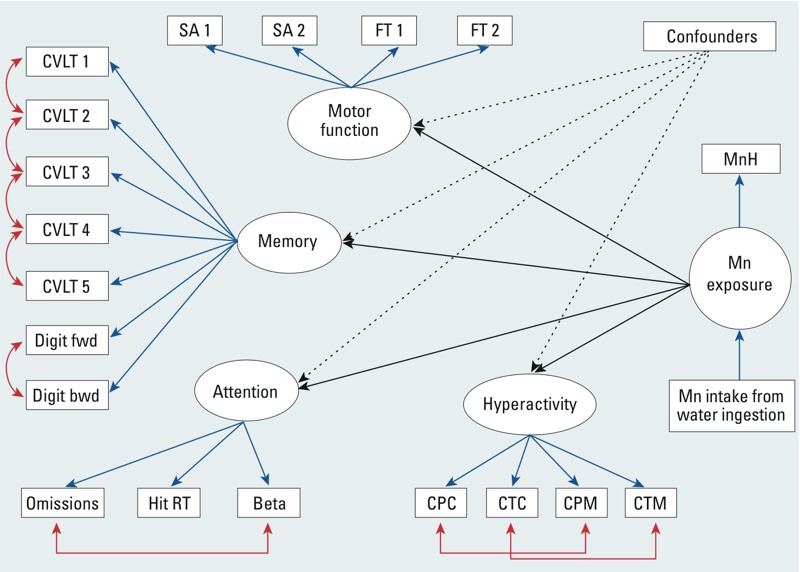
Conceptual path diagram for model 1 of the SEM for the associations between manganese exposure and neurobehavioral functions, with covariates adjustment. Manganese (Mn) exposure was modeled as a latent parameter indicated by hair manganese concentration (MnH), and influenced by manganese intake from water consumption. Four latent neurobehavioral functions were constructed: memory, attention, motor, and hyperactivity. The memory latent function was based on the number of correct responses on the learning trials of the CVLT–C for List A total trials 1–5 free recall (CVLT 1); List A, trial 1 free recall (CVLT 2); List A, trial 5 free recall (CVLT 3); Short delay free recall (CVLT 4); Long delay free recall (CVLT 5); Digit Span forward (Digit fwd) and backward (Digit bwd) scores. The attention latent variable was indicated by the scores of the CPT II test: number of failure to respond to target letters (omissions), overall hit reaction time (hit RT), and the response style indicator (beta). The attention test scores were reversed; therefore, higher attention scores indicate better performance. The motor function included scores on the Fingertapping [for dominant (FT 1) and nondominant (FT 2) hands] and the Santa Ana test [for dominant (SA 1) and nondominant (SA 2) hands]. The hyperactivity latent variable was indicated by parental (CPC) and teacher’s (CTC) hyperactivity and DSM-IV hyperactivity-impulsivity (CPM and CTM) scores from the Conners’ Rating Scales test. In models 2 and 3, the latent variable for manganese exposure was indicated solely by water manganese concentration, and manganese intake from water consumption, respectively.